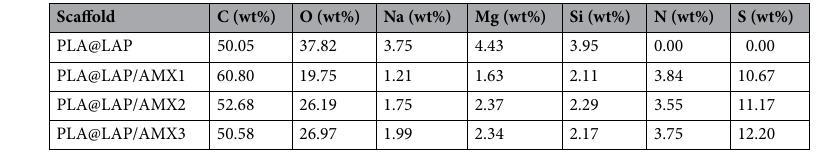
Table 2. Elemental composition of the surface of scaffolds obtained by EDX spectroscopy.